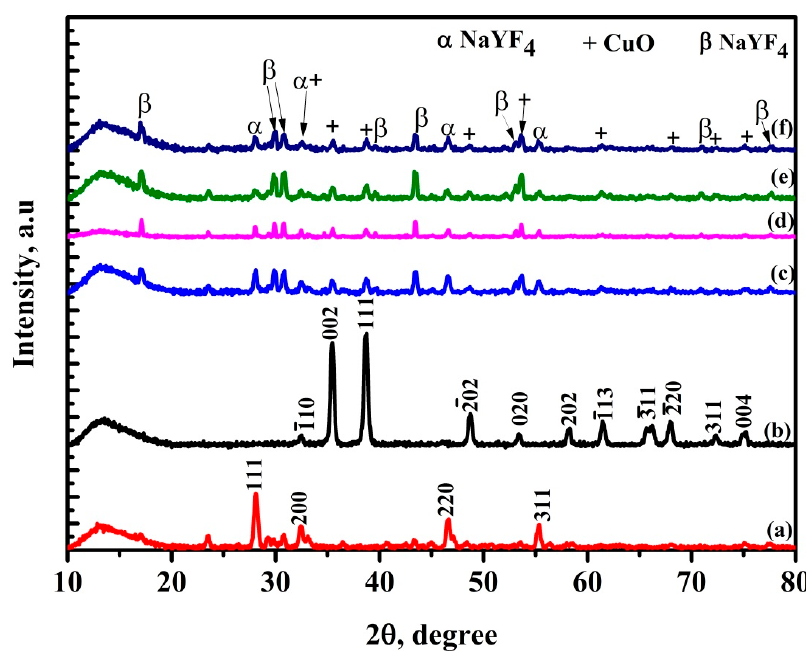
Figure 1. XRD spectra of ( a ) NaYF 4 :(Yb,Er), ( b ) CuO, ( c ) NaYF 4 :(Yb,Er)-CuO at 350 °C, ( d ) NaYF 4 :(Yb,Er)-CuO at 450 °C, ( e ) NaYF 4 :(Yb,Er)-CuO at 550 °C, and ( f ) NaYF 4 :(Yb,Er)-CuO/TiO 2 composite at 450 °C.